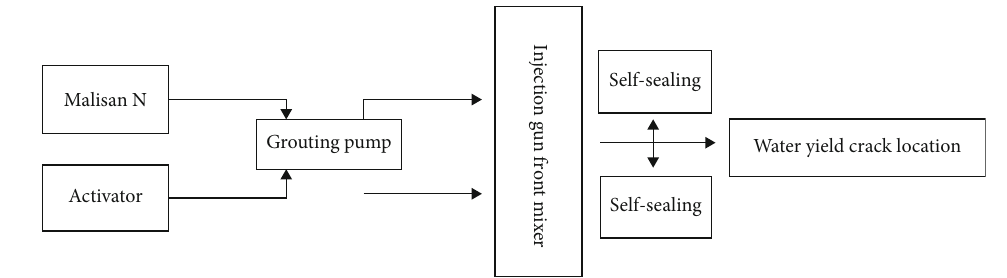
Figure 20: Grouting process fl ow chart.